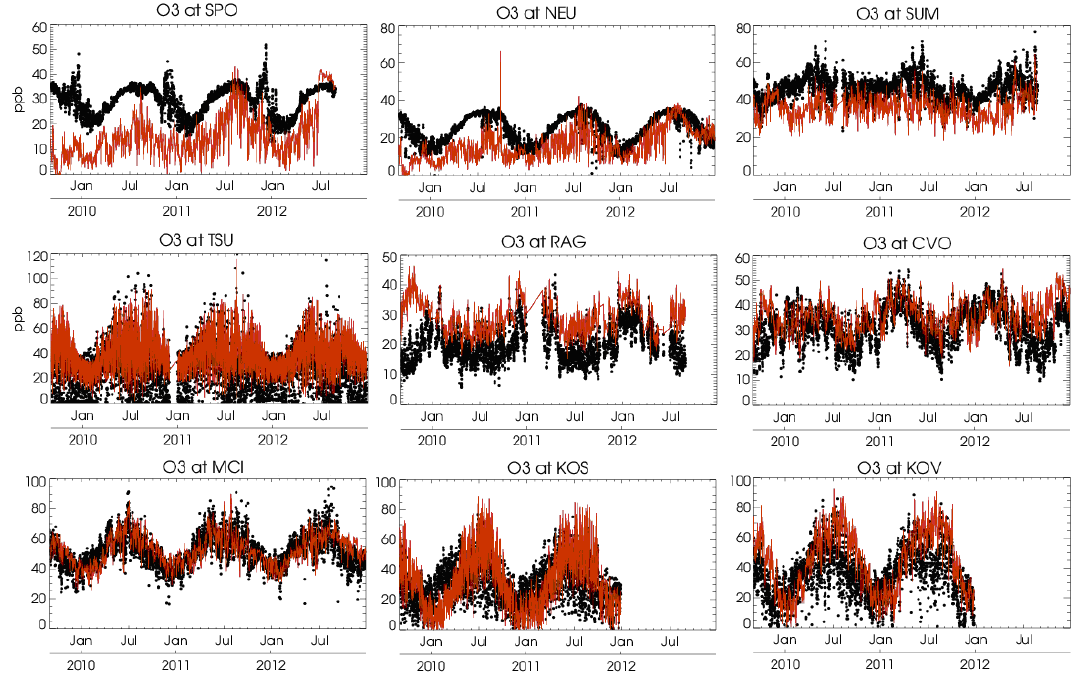
Figure 3. Time series plots of the MACC_osuite 6-hourly O 3 mixing ratios (red) and GAW surface observations (black) for South Pole, SPO (Antarctica); Neumayer, NEU (Antarctica); Summit, SUM (Denmark); Tsukuba, TSU (Japan); Ragged Point, RAG (Barbados); Cape Verde Observatory, CVO (Cape Verde); Monte Cimone, MCI (Italy); Kosetice, KOS (Czech Republic); and Kovk, KOV (Slovenia) during the period September 2009 to December 2012. Unit: